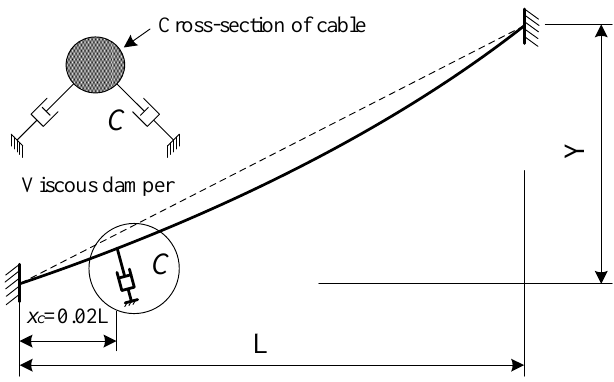
Figure 9. Stay cable with viscous damper.